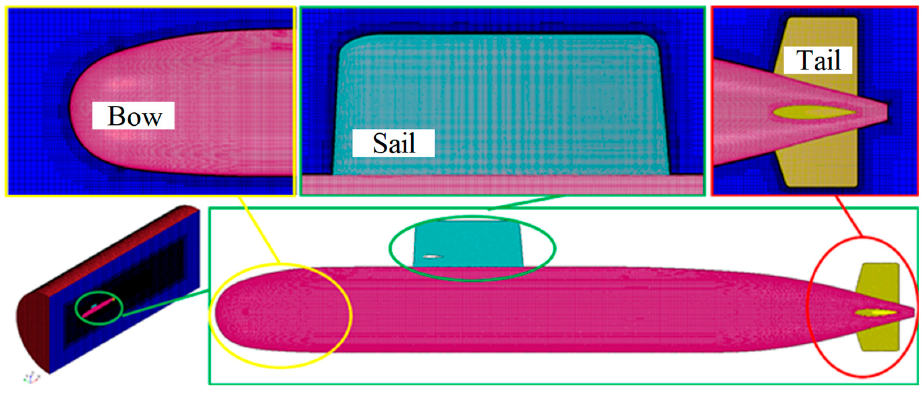
Figure 3. Mesh distribution.